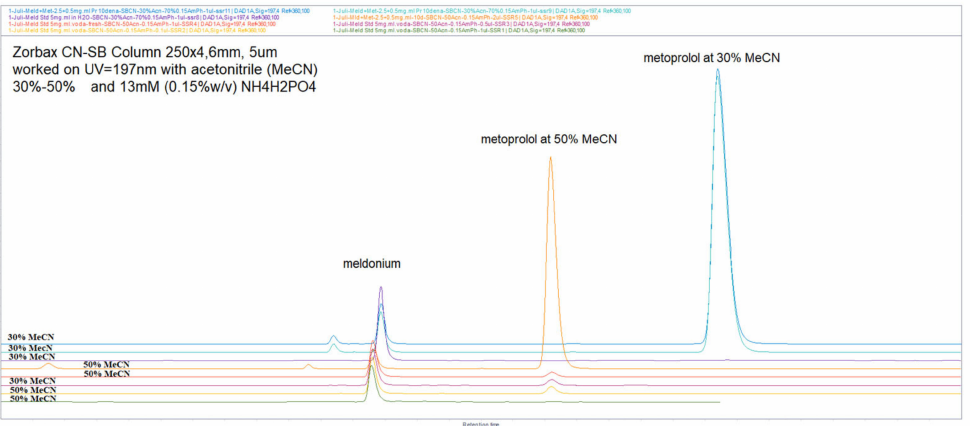
Figure 35. Chromatograms of retention time mapping with significant changes of organic percentage of ACN with 13 mM NH 4 H 2 PO 4 in mobile phase, comparison of overlaid retentions of analytes on chromatograms using column Zorbax CN-SB-250 × 4.6